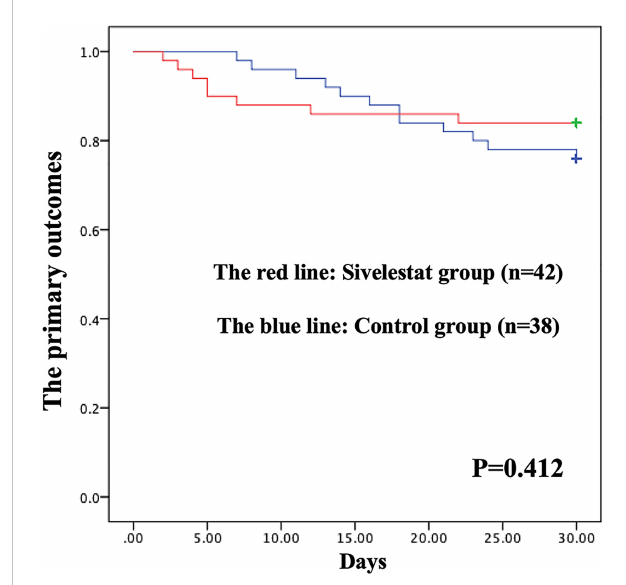
FIGURE 3 Kaplan-Meier (K-M) curves showing the primary outcomes had no difference between the two groups in propensity-matched patients during 30-days